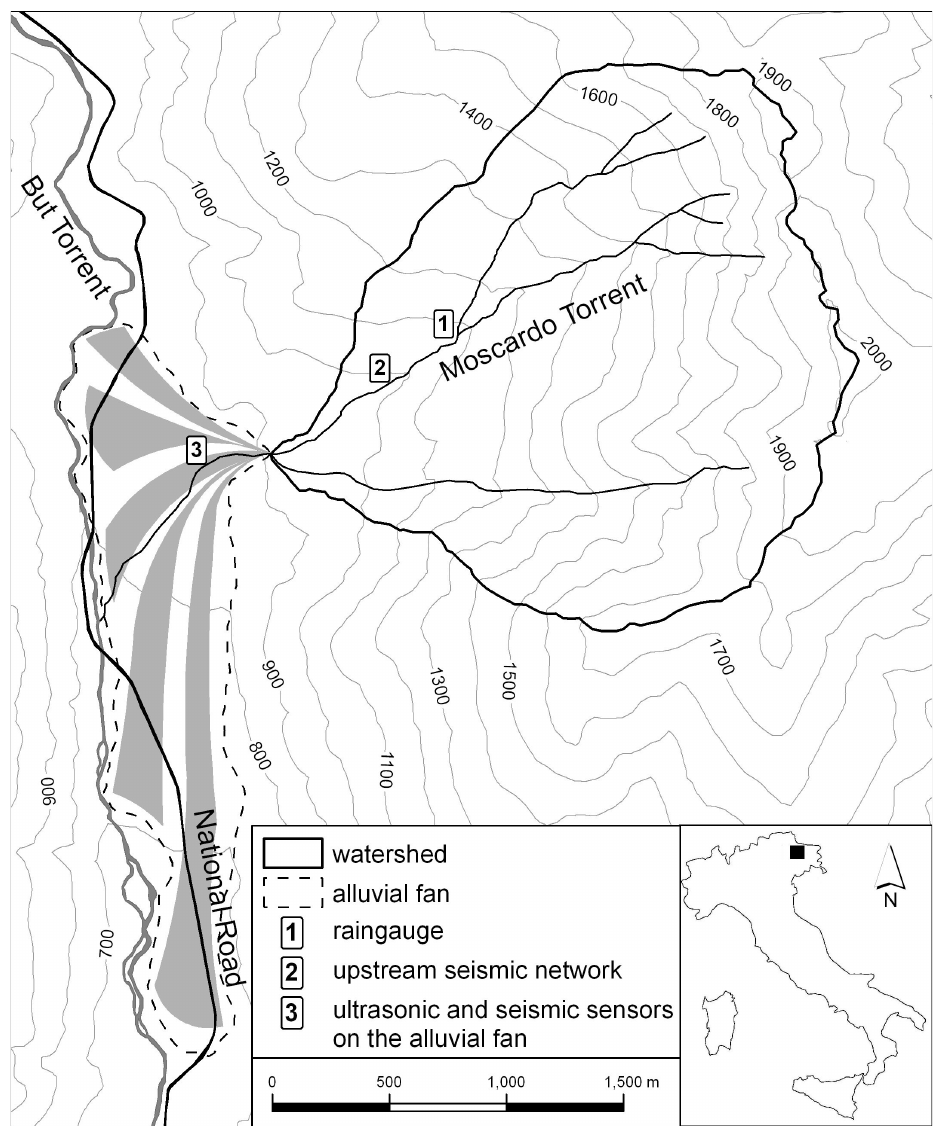
Fig. 1. The Moscardo Torrent basin, its alluvial fan and the monitoring equipment working in the summer of 2006: (1) rain gauge; (2) up- stream seismic network; (3) ultrasonic and seismic sensors on the